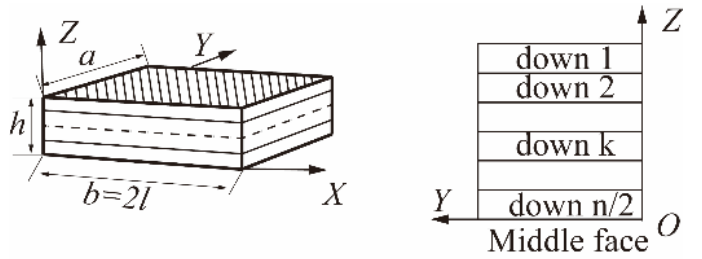
Figure 5. Structure and geometric dimensions of the laminate model.